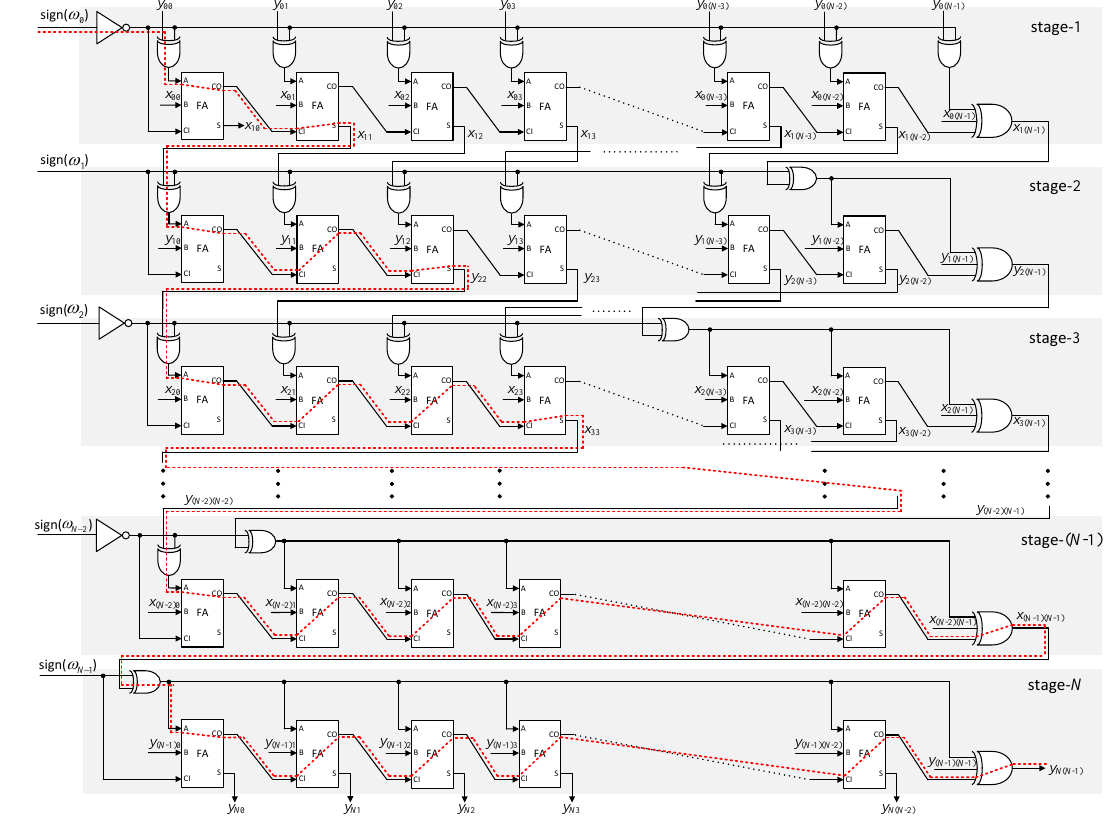
Figure 2. Detailed bit-level block diagram and critical path of an N -stage non-pipelined cascaded CORDIC without an angle update circuit. The word length L is assumed to be equal to the number of stages N